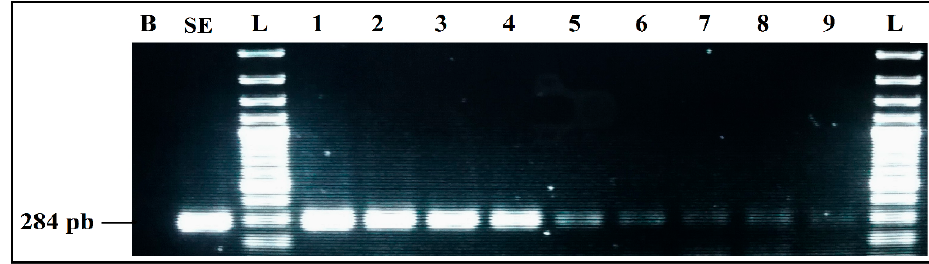
Figure 5. Detection sensitivity of S. enterica primers SalinA 284 bp, in Simplex PCR. B, negative control; SE, positive control S. enterica 4266 CECT; L, 100 bp DNA ladder; lane 1 to 9, PCR results from 4547 pg/ µ L to 0.00005 pg/ µ L DNA; L, 100 bp DNA ladder.